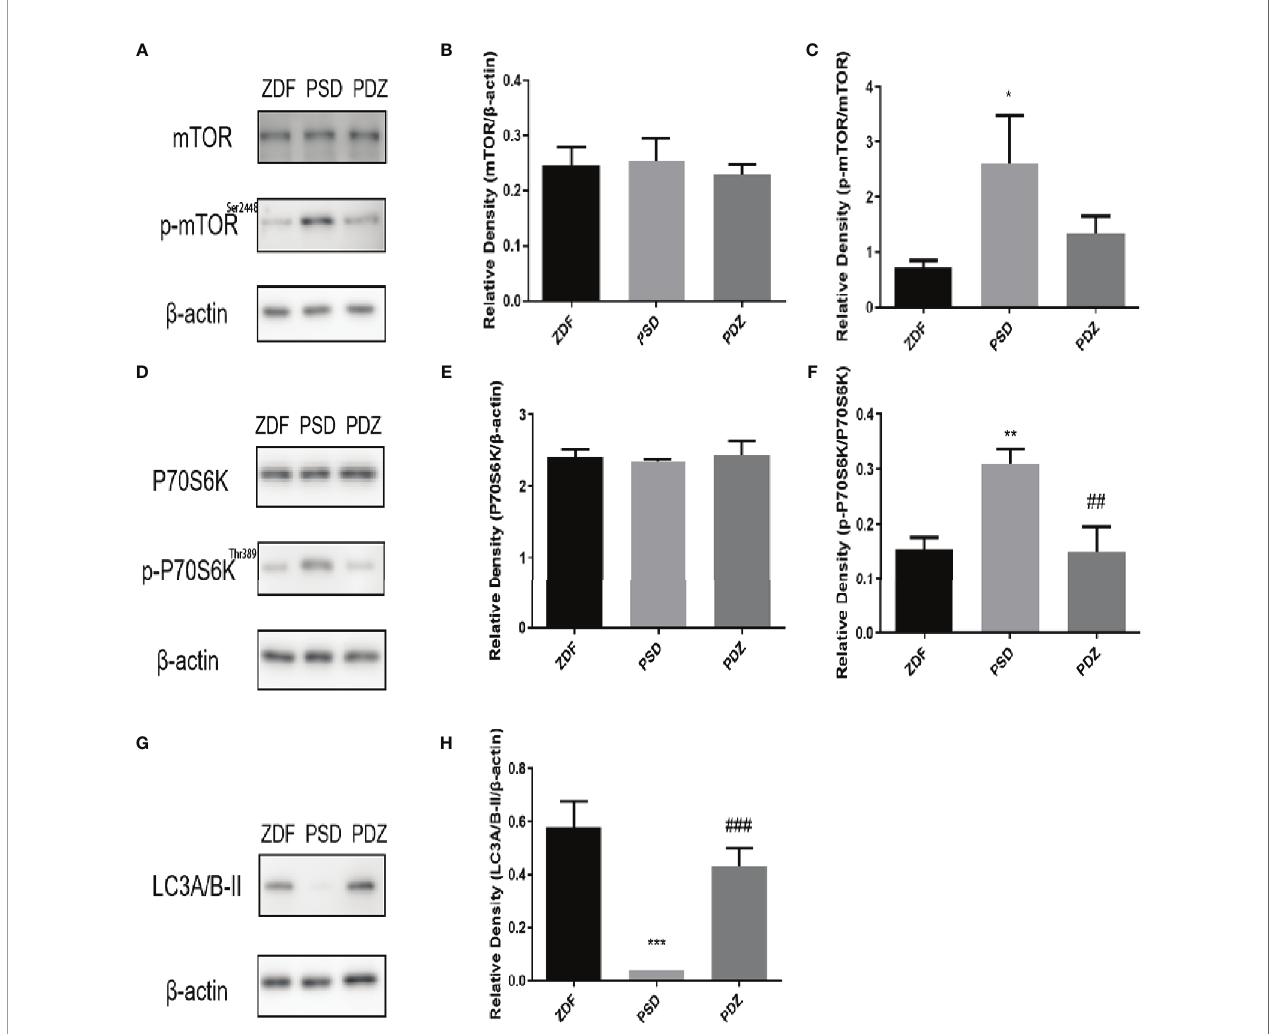
FIGURE 8 | Effect of ZBPYR on the mTOR-autophagy pathway in the mPFC of ZDF rats. Protein expression of mTOR and p-mTOR in the mPFC of each group (A – C) . Protein expression of P70S6K and p-P70S6K in the mPFC of each group (D – F) . Protein expression of LC3A/B in the mPFC of each group (G – H) . Bars represent the mean ± SEM. * P < 0.05, ** P < 0.01, *** P < 0.001, PSD group vs. ZDF group; ## P < 0.01, ### P < 0.001, PDZ group vs. PSD